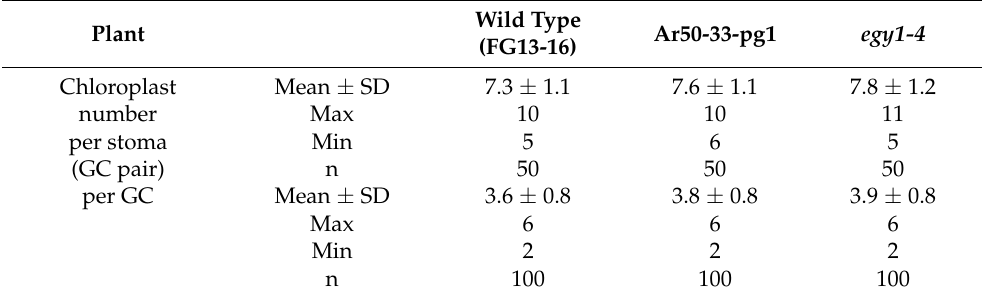
Table 1. Plastid number in leaf stomatal guard cells of wild-type plants and mutant lines